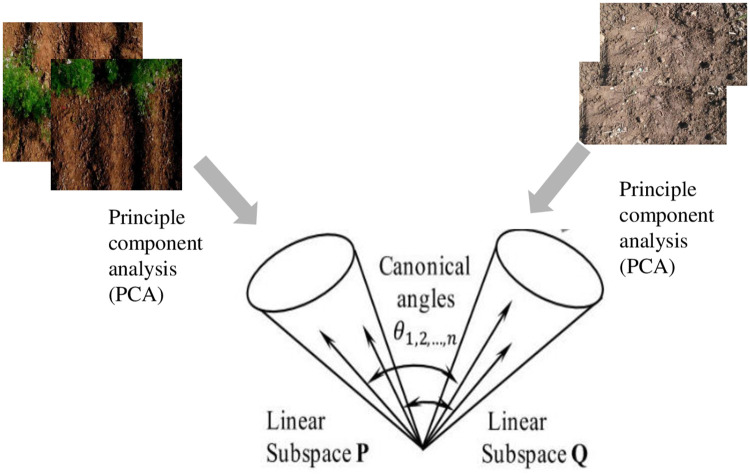
MSM for comparing two sets of images [31].